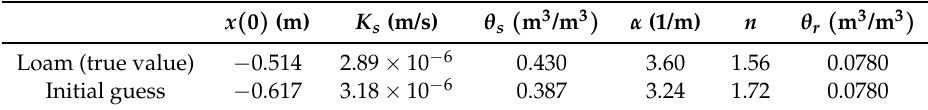
Table 2. True values of initial states and parameters of the process and the initial guesses used in filters and estimator.